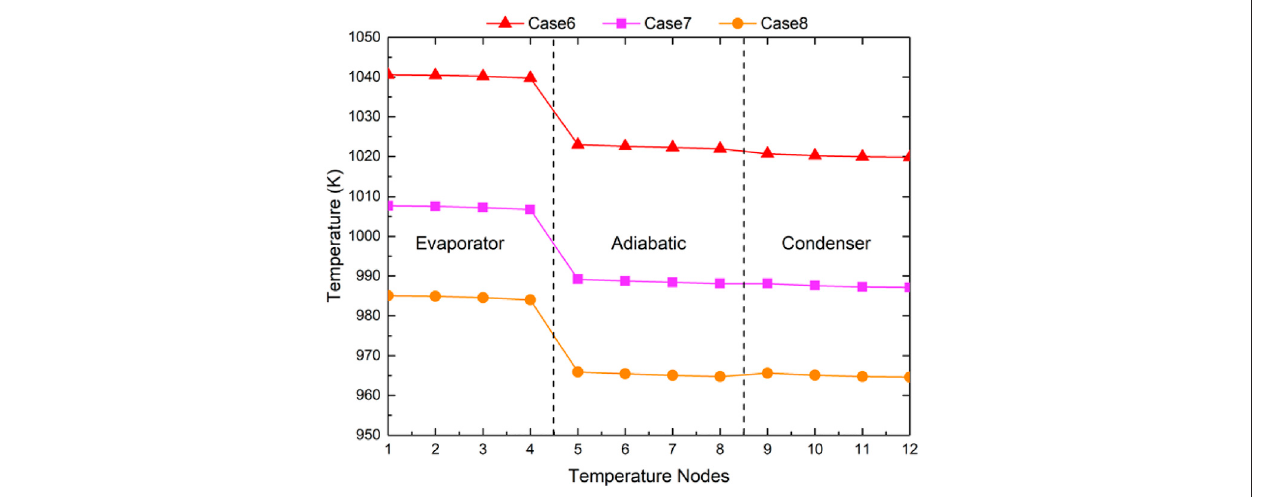
FIGURE 21 | Schematic diagram of heat leakage of the heat pipe.